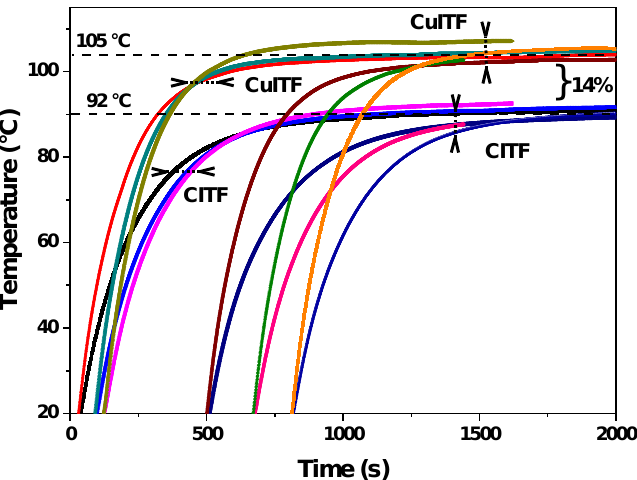
Figure 10. Temperature behavior as a function of time for six runs for each furnace. The displacement in time corresponds to different procedure start times.